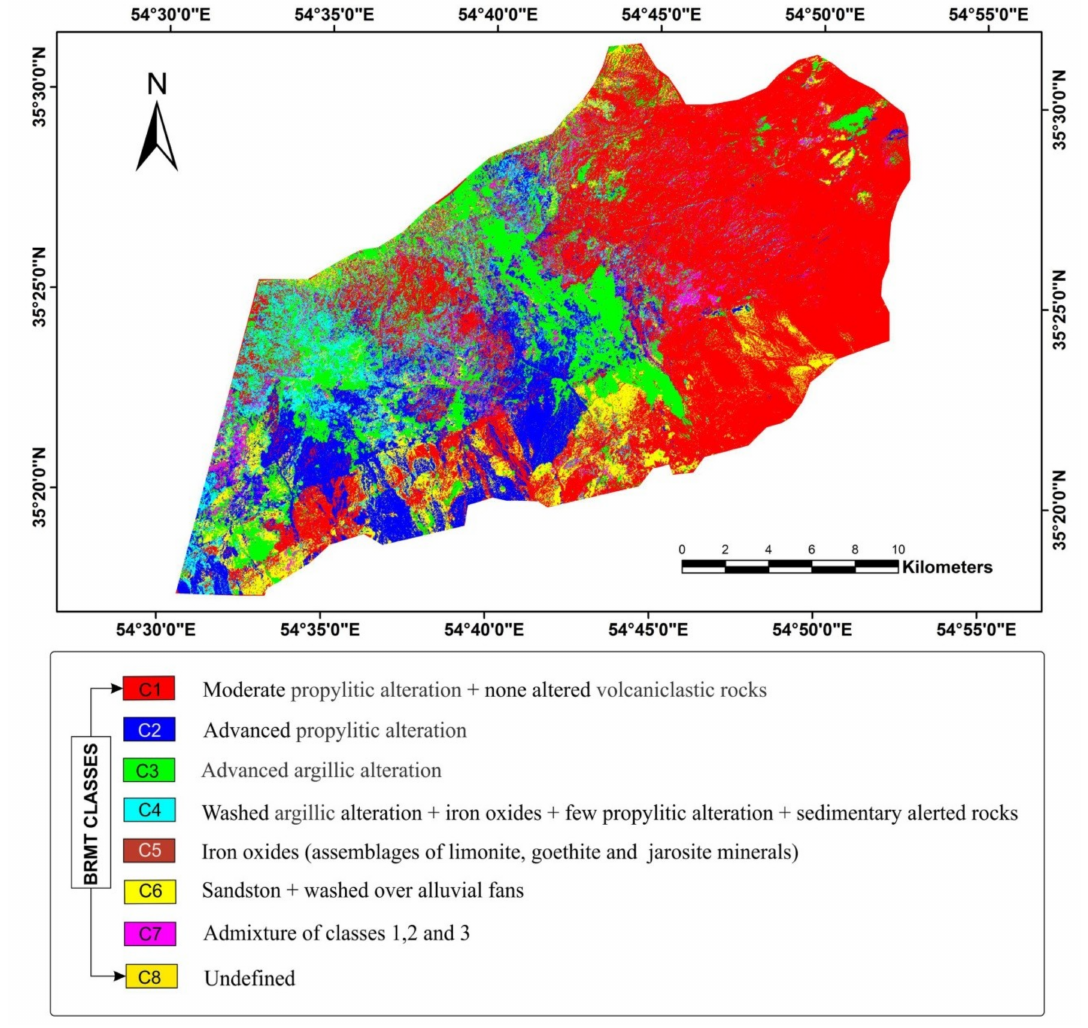
Figure 7. BRMT classification map for the study